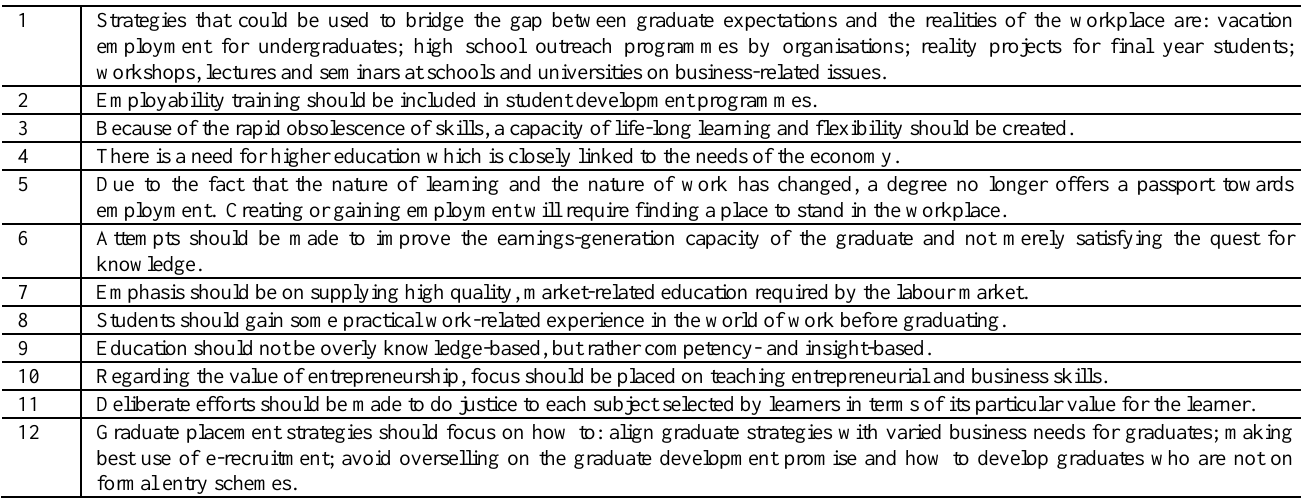
Table 4: Guidelines and recommendations to ensure realistic expectations of graduates before entering the